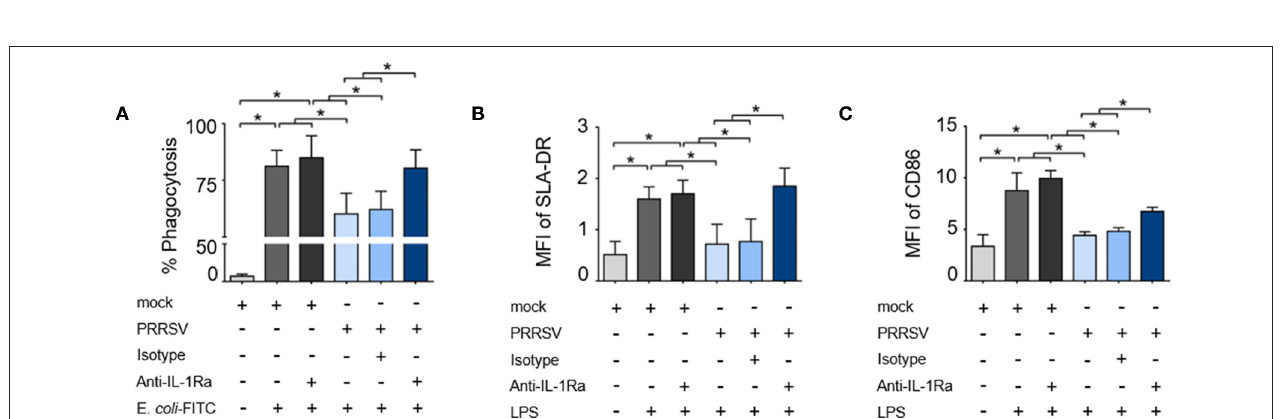
FIGURE 1 | PRRSV-induced IL-1Ra inhibited porcine innate immune functions. PRRSV-induced IL-1Ra inhibited (A) phagocytic activity, (B) SLA-DR and (C) CD86 expression. MoDC were cultured with type 2 PRRSV or mock, in the presence of anti-IL-1Ra Ab. LPS was added into the culture and further incubated for 24h. ± indicates presence/absence of indicated treatment within the culture. Data represents mean ± SD from 5 pigs. Statistical significance was analyzed using ANOVA followed by Tukey’s test. * indicates significant difference at p < 0.05.